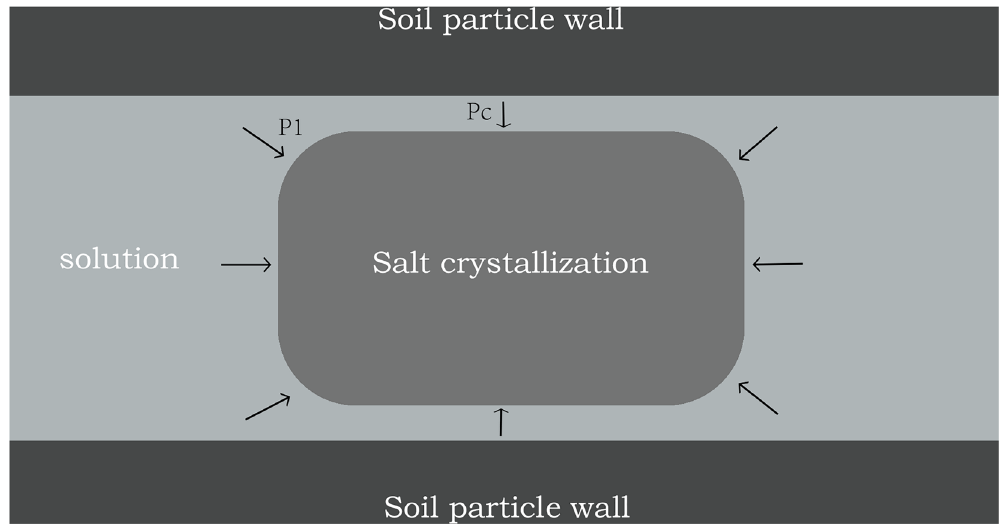
Figure 6. Schematic diagram of salt crystal crystallization between soil particles 34